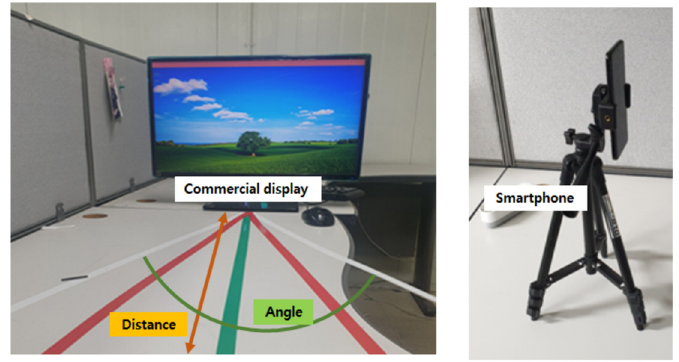
Figure 10. The experimental environment with a commercial display and a mobile